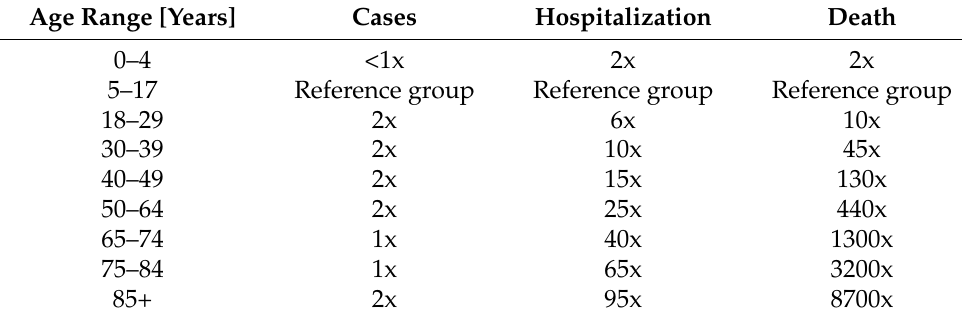
Table 1. The main factors underlying severe COVID-19 infection